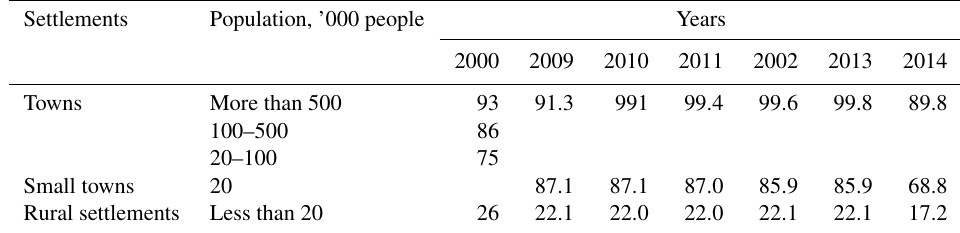
Table 2. Centralized water supply of settlements in Ukraine.